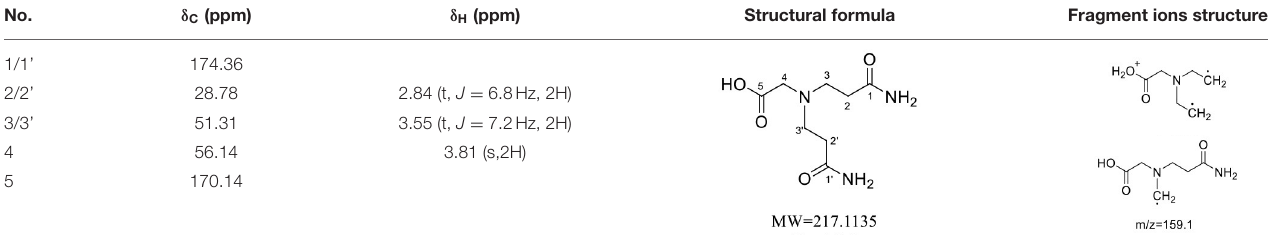
TABLE 9 | NMR spectra data of Gly-AA 2 measured in D 2 O.